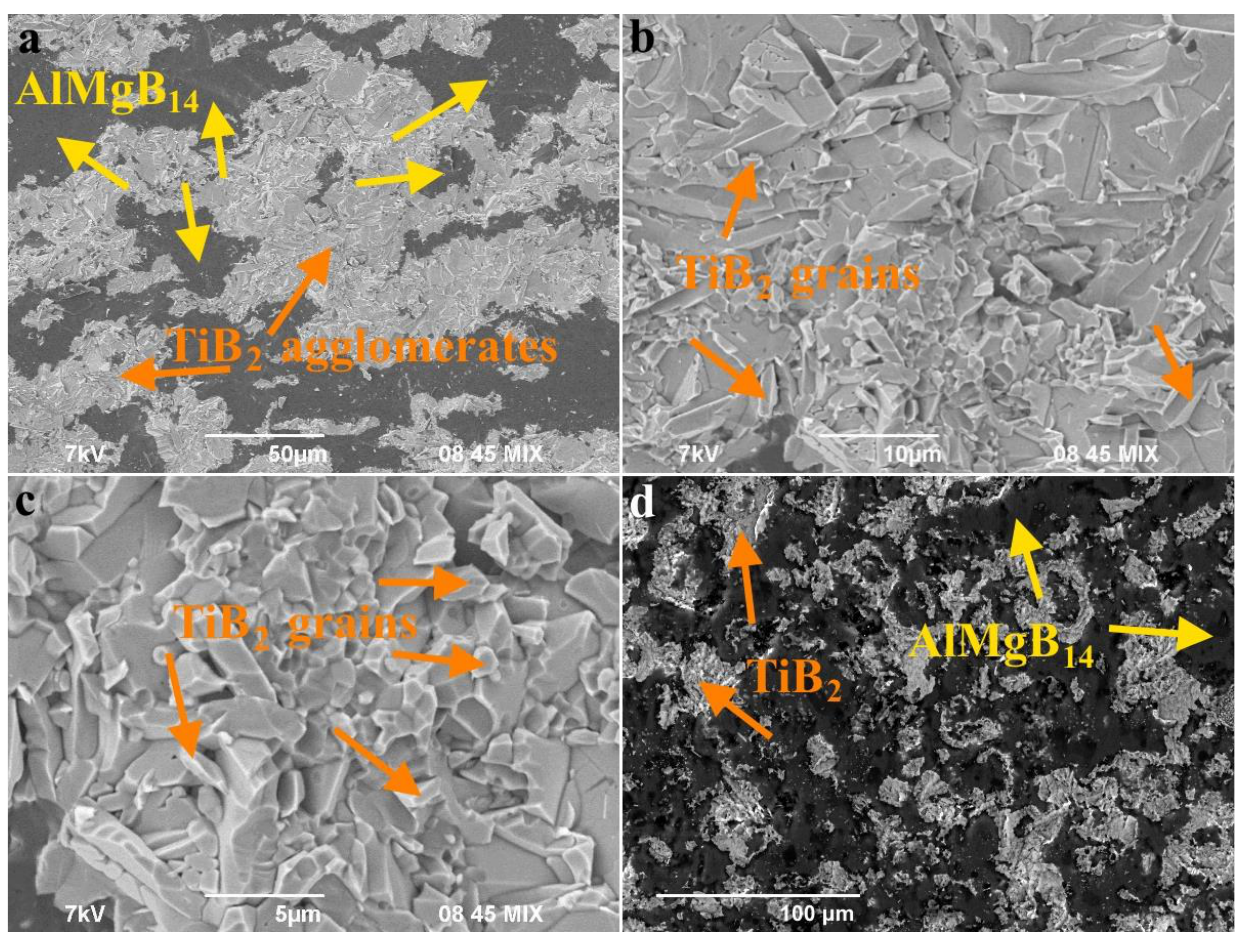
Figure 3. SEM images of the fracture surface ( a – c ) and the surface ( d ) of the AlMgB 14 -TiB 2 composite.